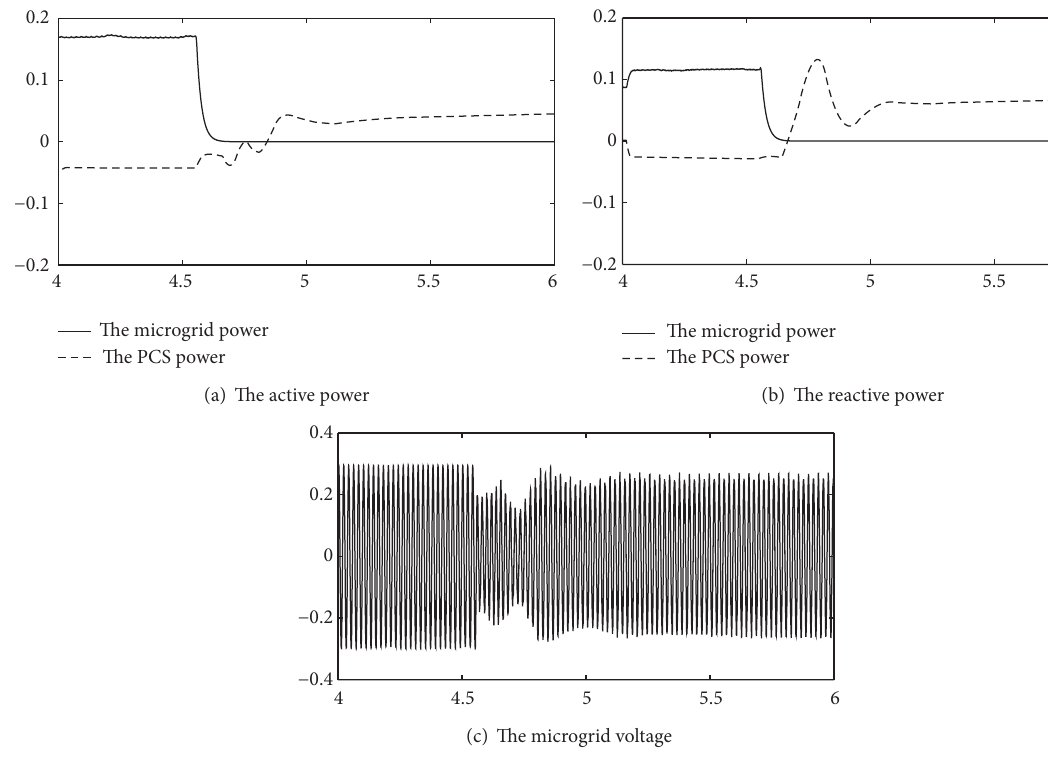
Figure 7: Operation results